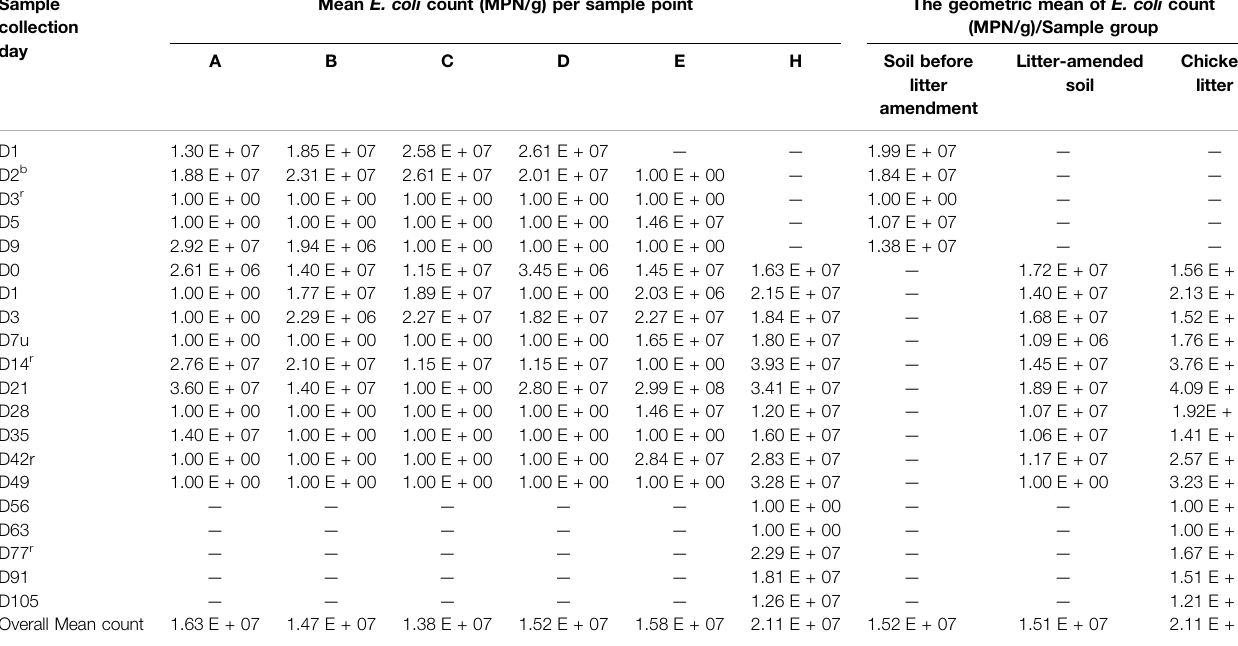
TABLE 1 | Mean E. coli counts ((MPN/g) throughout the sample collection. Sample collection